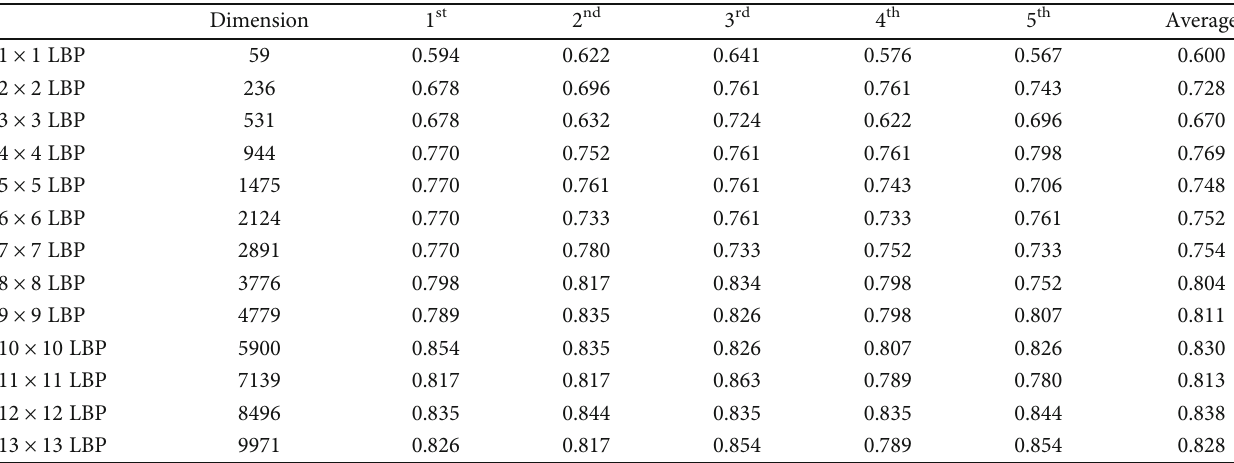
Table 3: Classi fi cation results of di ff erent LBP features in 5 times 10-fold cross